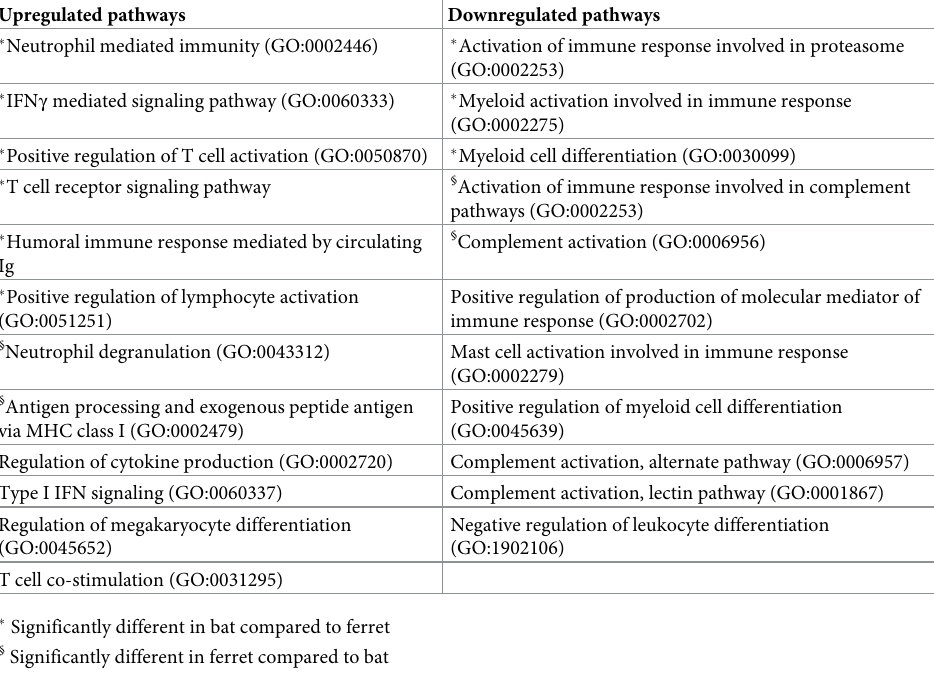
Table 1. Pathway enrichment in bat and ferret lung proteomics identified by GO